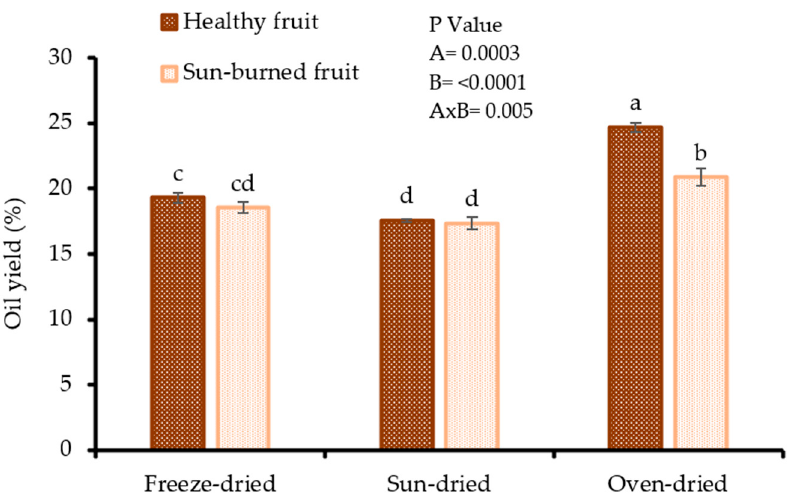
Figure 1. Oil yield from seeds of healthy and sun-burned fruits and dried under different drying methods. Factorial ANOVA was performed for Factor A (fruit quality), and Factor B (seed drying method). Columns followed by different letters are significantly different ( p < 0.05) according to Duncan’s multiple range test. Vertical bars indicate the standard deviation of the mean. Table 1. Refractive index (RI), anisidine value (AV), DPPH radical scavenging ability, and tyrosinase enzyme inhibition of oil from seeds of healthy and sun burned fruit and dried under different drying